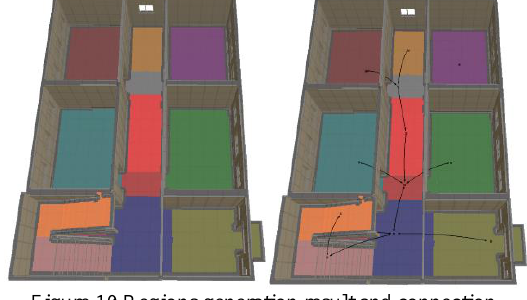
Figure 10 Regions generation result and connection between regions The contour and navigation meshes generation results